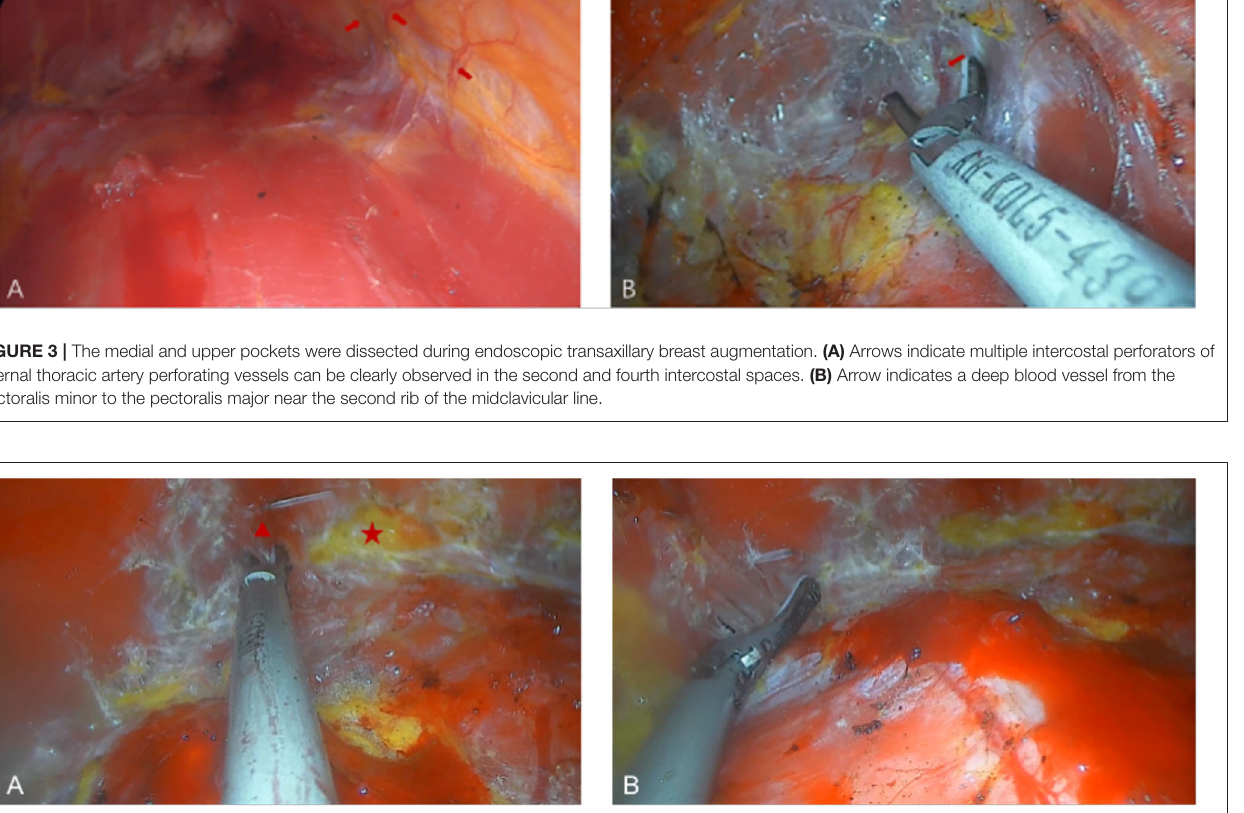
FIGURE 4 | Dissecting the lower pocket during endoscopic transaxillary breast augmentation. (A) The attachment points of the pectoralis major around the inframammary fold were transected, the triangle and the star indicate the pectoralis major muscle, and the adipose tissue after the pectoralis major muscle is severed, respectively. (B) Transection of the pectoralis major muscle to separate the outer boundary of the pocket.